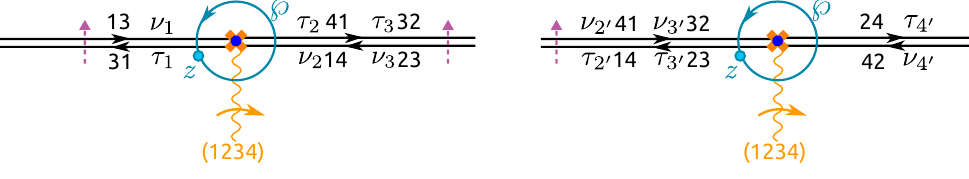
Figure 5 . The loops around the full punctures z 2 = ! (left) and z 1 = 1 (right) for which we compute the framed 2d-4d BPS spectrum.